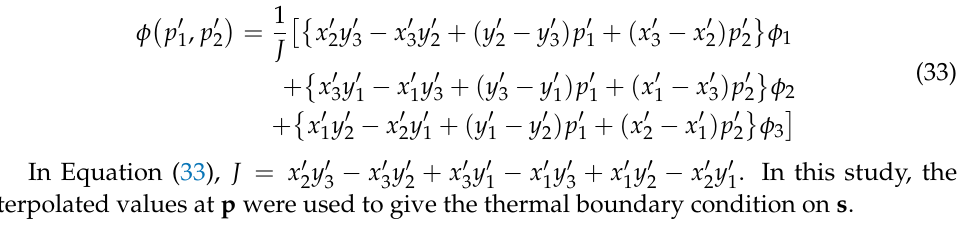
, e (cid:48) , e (cid:48) 2 3 1